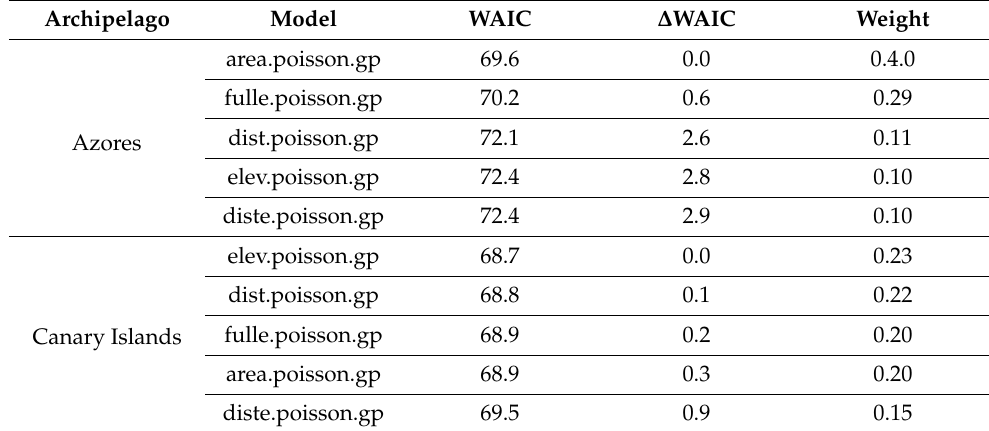
Table 10. Comparison of the several models using the “Widely Applicable Information Criterion” (WAIC) criterion for the multiple island endemic species (MIE). Only models with ‘weight’ greater than 0.01 are shown. See the captions of Tables 3 and 6 for the explanation of the